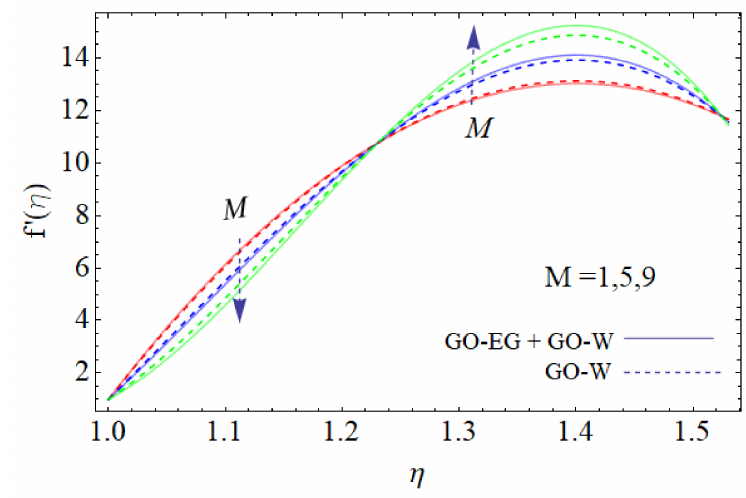
Figure 6. Influence of the magnetic field parameter on the velocity profile.